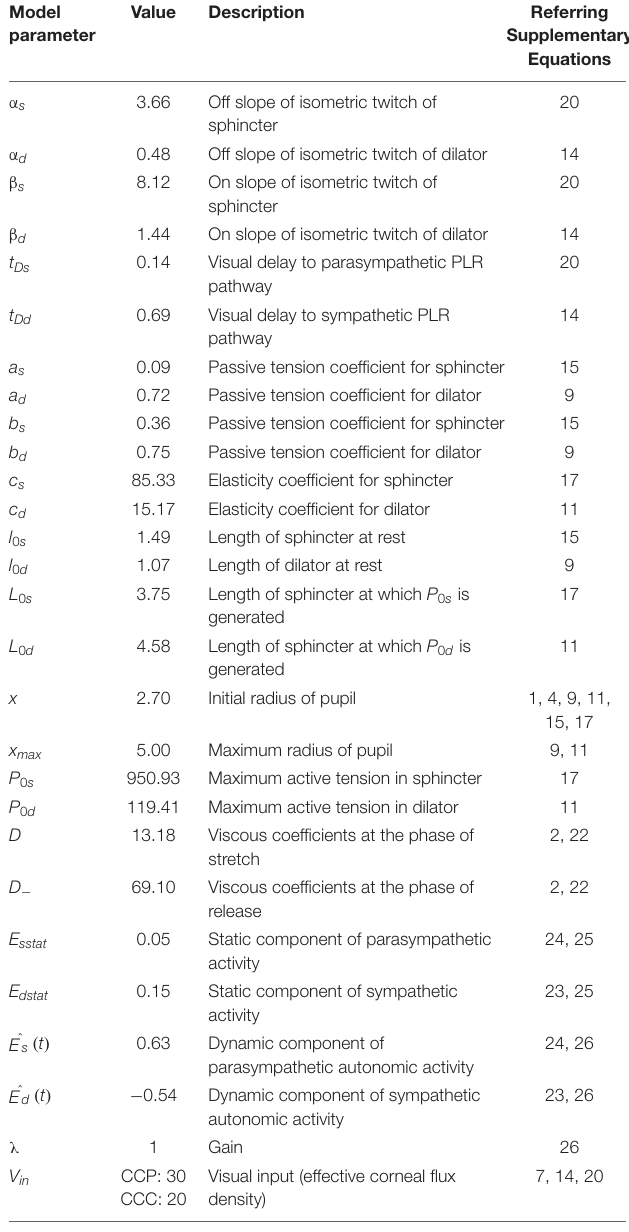
TABLE 1 | Parameters used for the simulation of a biomechanical model of pupillary light response